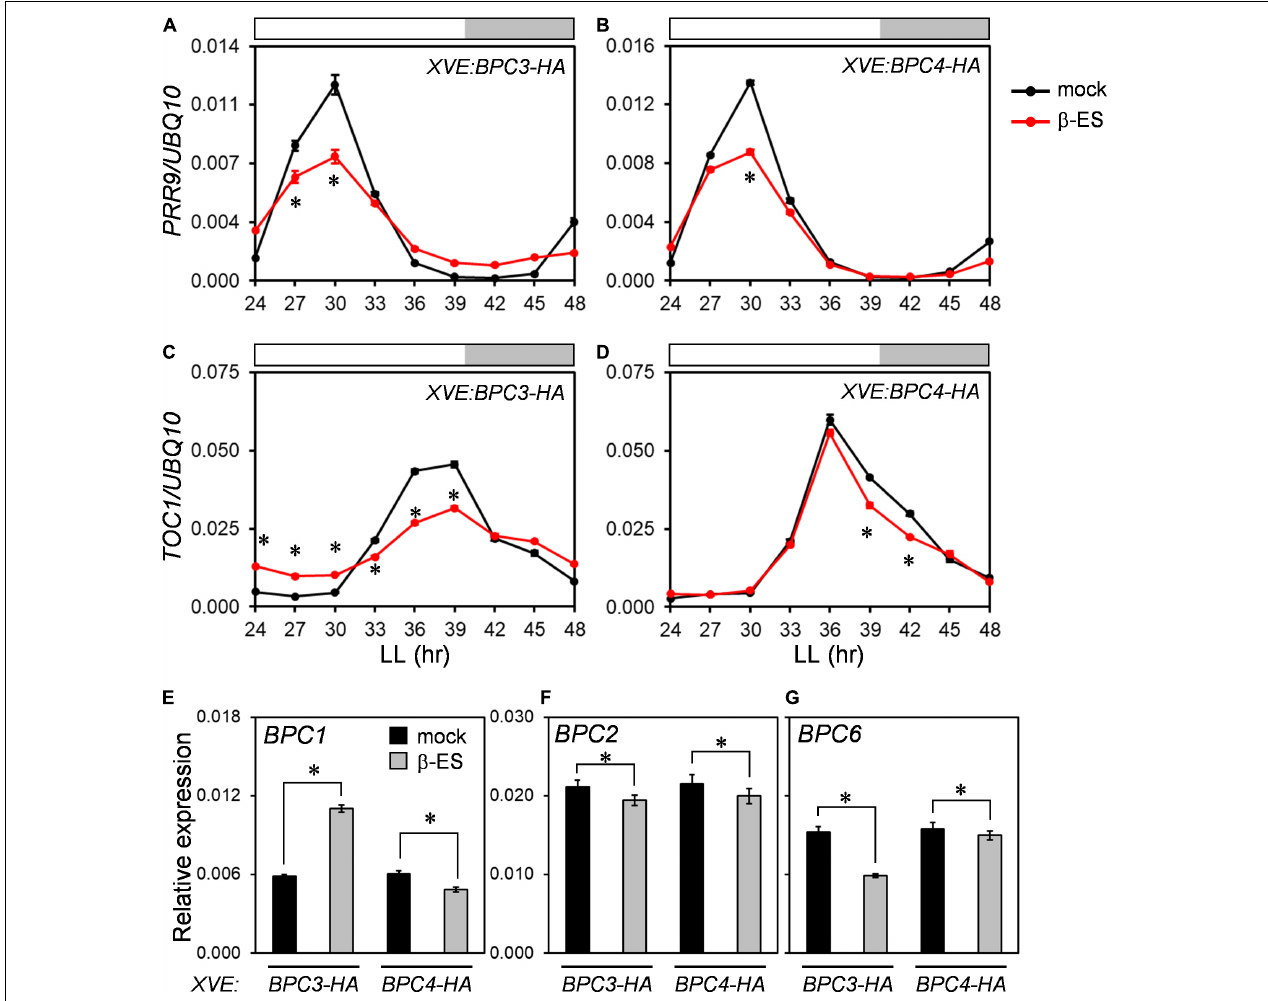
FIGURE 7 | BPCs negatively regulated circadian clock components. (A–D) qRT-PCR analyses for expression profiles of PRR9 (A,B) and TOC1 (C,D) under the induction of BPC3-HA (A,C) and BPC4-HA (B,D) transgenic lines as described in Figures 6A–D . (E–G) Expression levels of BPC1 (E) , BPC2 (F) , and BPC6 (G) were profiled under BPC3-HA or BPC4-HA induction. Asterisks indicate the transcript levels were significantly changed by the β -ES treatment (Student’s t- test; ∗ P < 0.05). Data are mean ± S.E. ( n = 27, data collected as described in Figure 3 ; an independent biological replicate and corresponding individual time points are presented in Supplementary Figure 9